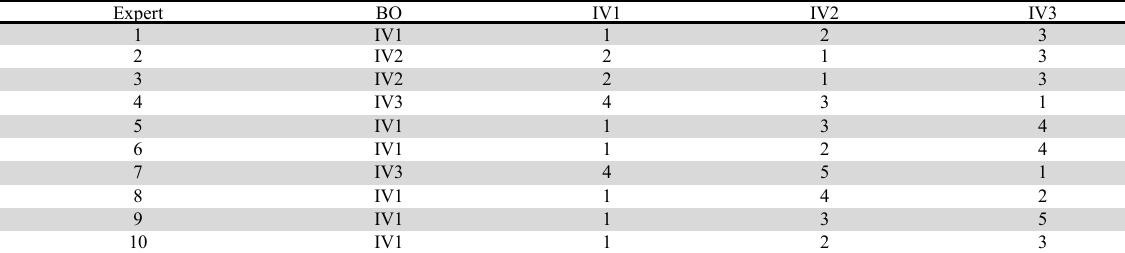
Informational value preferences (Best to others)